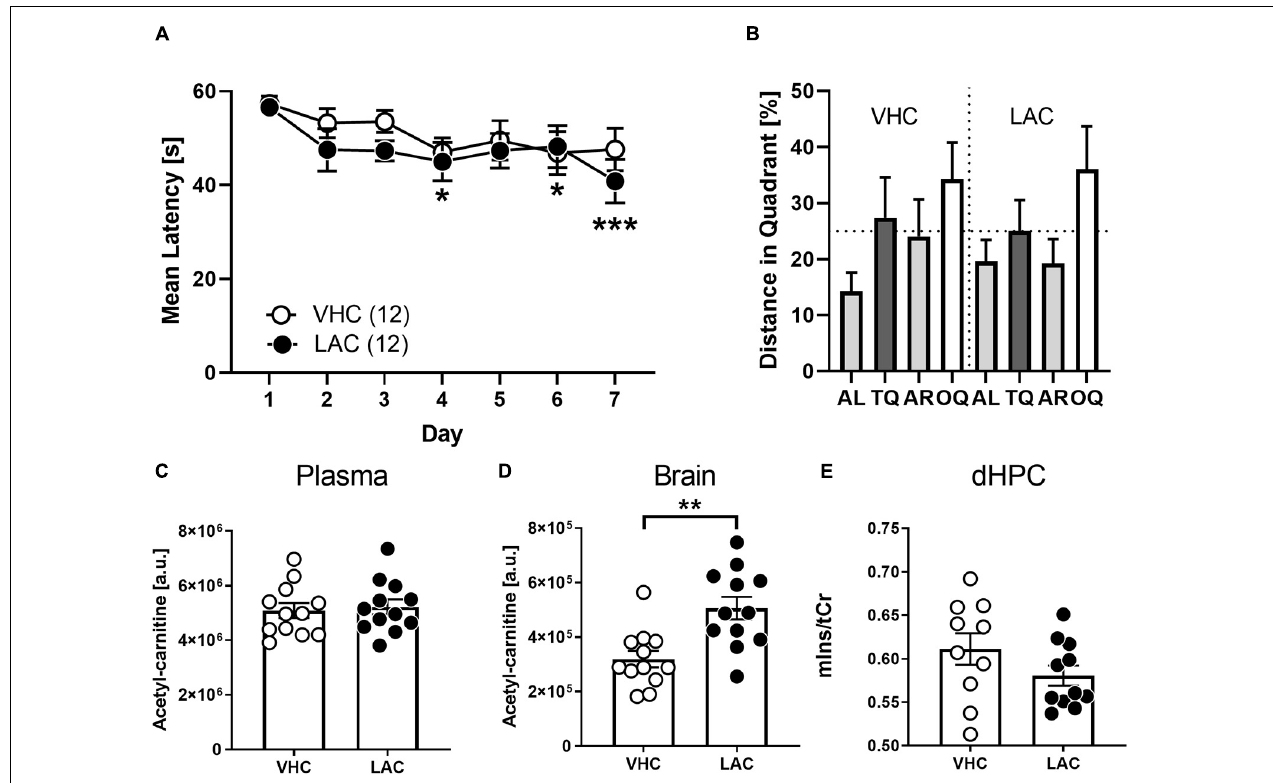
FIGURE 6 | Supplementation of LAC did not invert cognitive deficits of BALBc mice. Ten weeks old LAC-treated BALBc ( n = 12) and vehicle (VHC)-treated BALBc mice ( n = 12) performed MWM training over the course of 7 days, followed by In vivo 1 H-MRS measurements. No consistent differences in spatial learning or memory were observed comparing (A) escape latencies or (B) distance in target quadrant. (C) While oral supplementation of LAC via the drinking water did not affect plasma LAC levels, (D) brain LAC levels were significantly elevated. (E) In vivo 1 H-MRS measurements revealed no differences in dorsal hippocampal mIns levels between both groups. [AL, adjacent left quadrant; AR, adjacent right quadrant; OQ, opposite quadrant; TQ, target quadrant; tCr = total creatine (creatine + phosphocreatine)]. * p < 0.05, ** p < 0.01, *** p < 0.001 vs. other strain or TQ (2-way ANOVAs followed by Tukey’s post hoc test or unpaired t